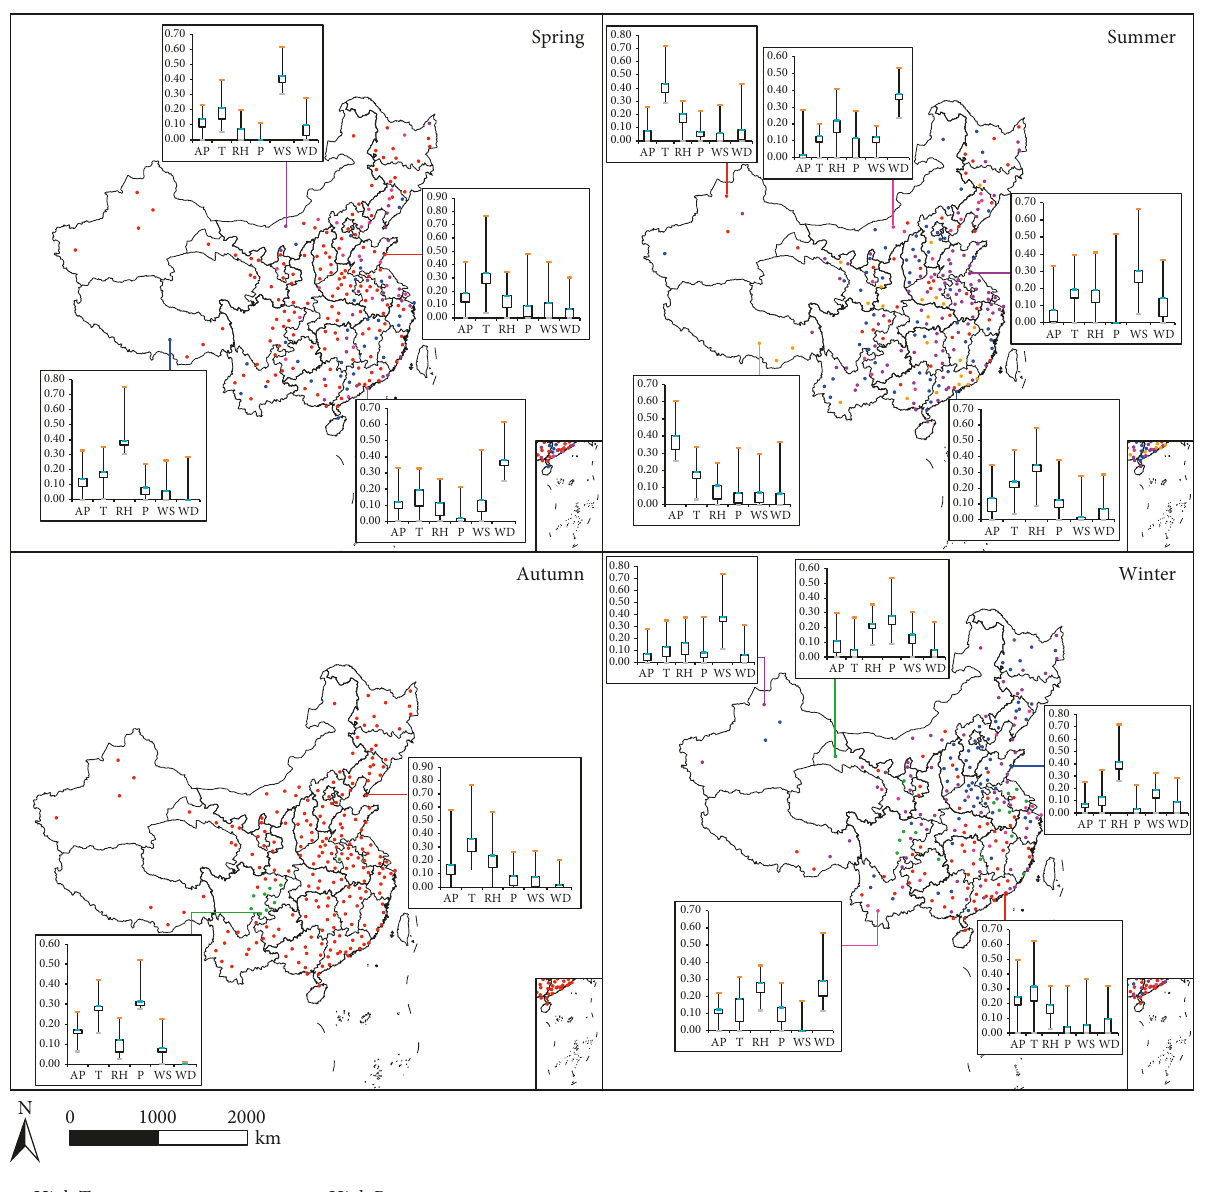
Figure 13: Relationship between CO concentration and meteorological